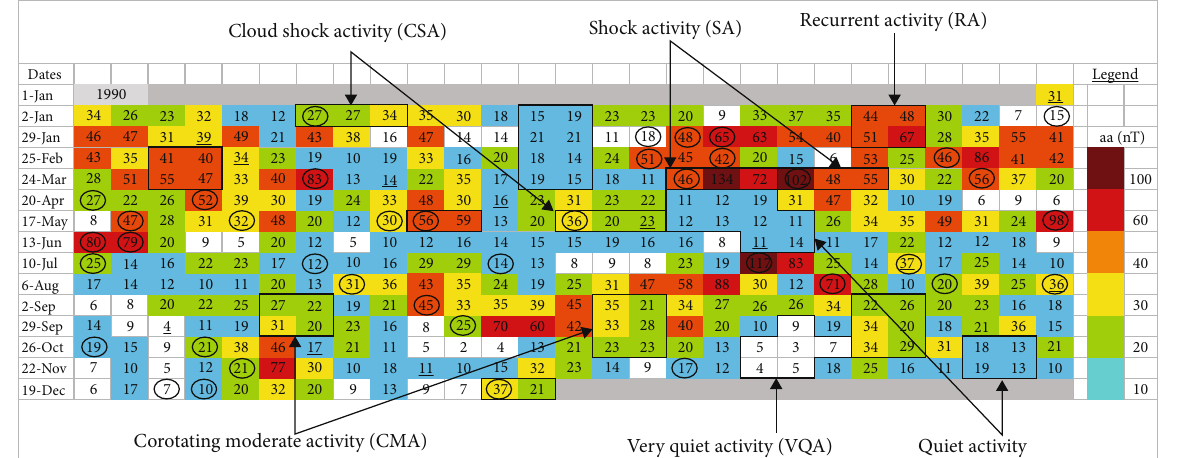
Figure 1: Pixel diagram showing di ff erent geomagnetic activities ’ classes according to NC